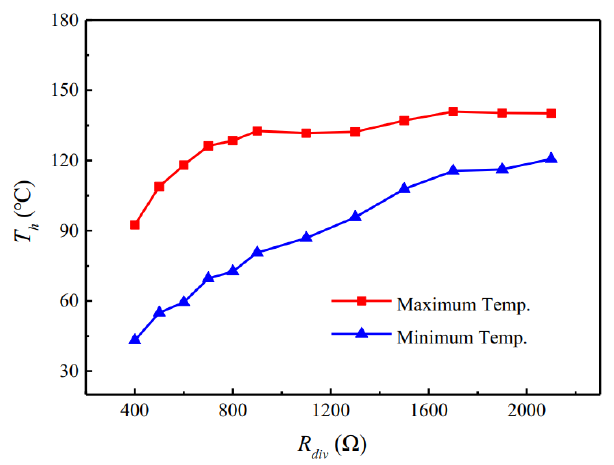
Figure 11. Relationship between the average maximum / minimum temperatures and the R div , varied from 400 Ω to 2100 Ω.